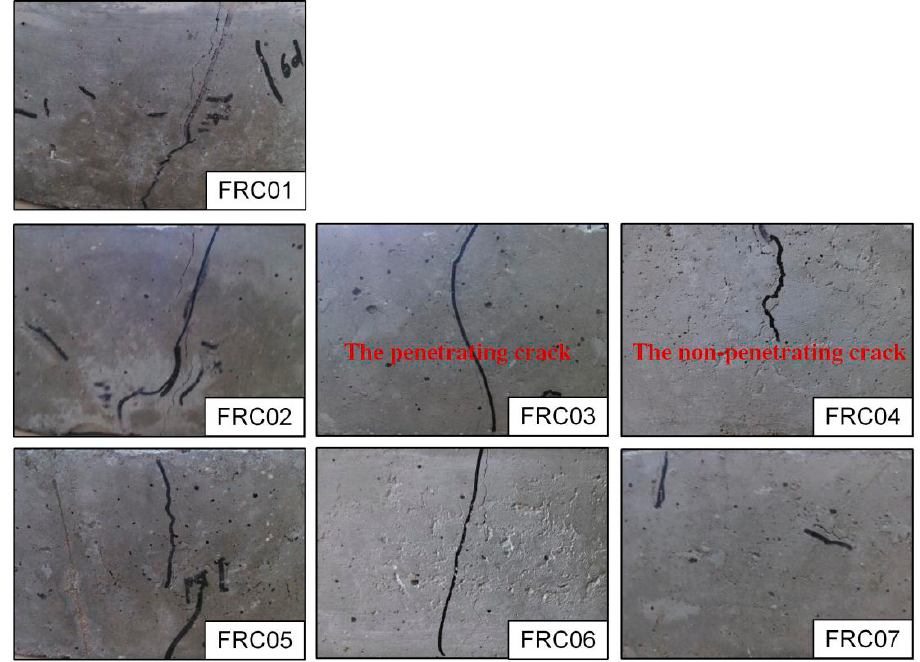
Figure 12. Cracking phenomena of circular concrete specimens.